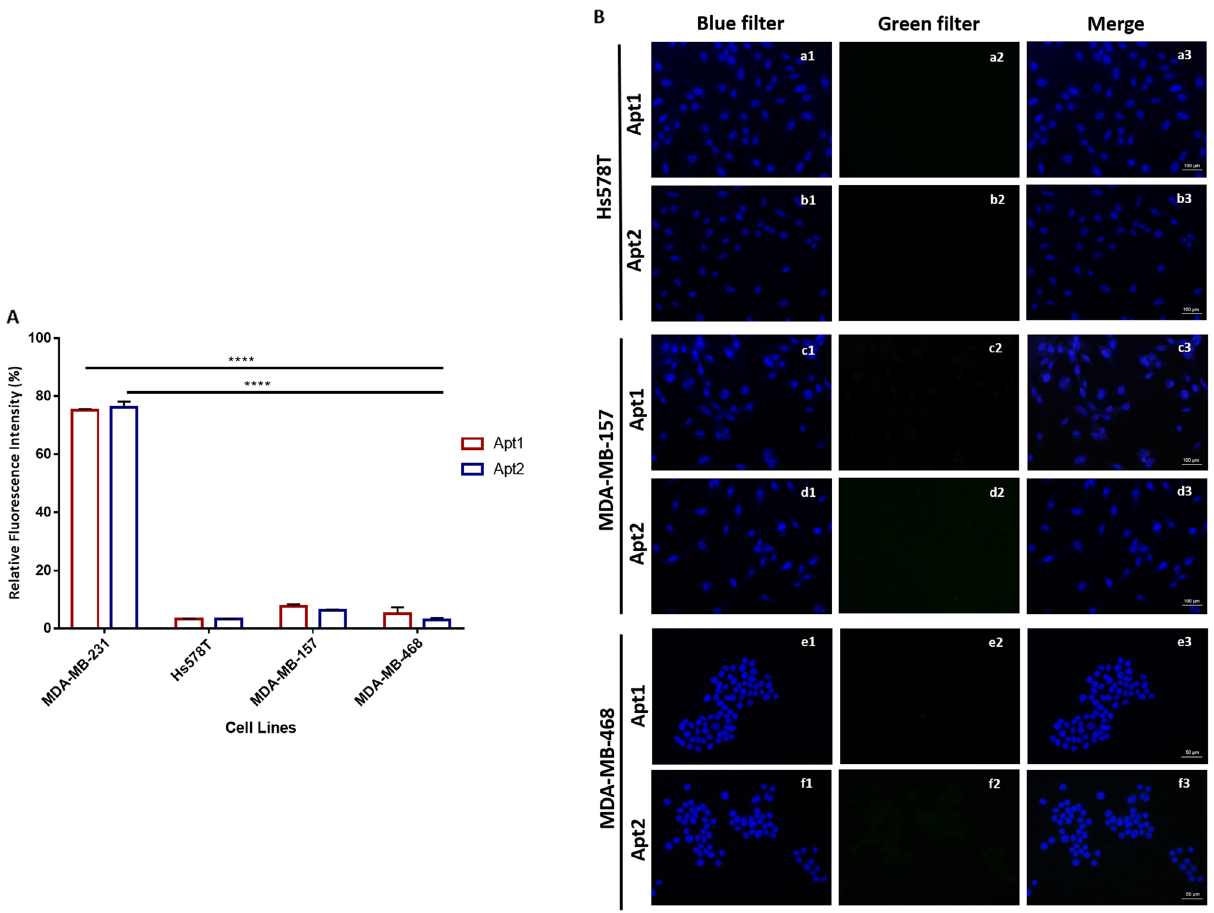
Figure 6. Binding specificity of Apt1 and Apt2 aptamers to other TNBC cell lines. ( A ) FAM-labelled Apt1 and Apt2 were incubated at 37 °C with Hs 578T, MDA-MB-157 and MDA-MB-468 cell lines and analyzed by flow cytometry. Two-way ANOVA indicates statistically significant differences within the group assessed by Sidak’s post-test and denoted as follows: ****ρ ≤ 0.0001, ***ρ ≤ 0.001 and **ρ ≤ 0.001. ( B ) Microscopy results showing the fluorescence imaging of Hs 578T (a and b), MDA-MB-157 (c and d) and MDA-MB-468 (e and f) cells incubated with FAM-labelled Apt1 and Apt2 at 37 °C, respectively. (1) blue filter, nuclei stained with DAPI, (2) green filter, Apt1 or Apt2, and (3) merge of all filters (1 and